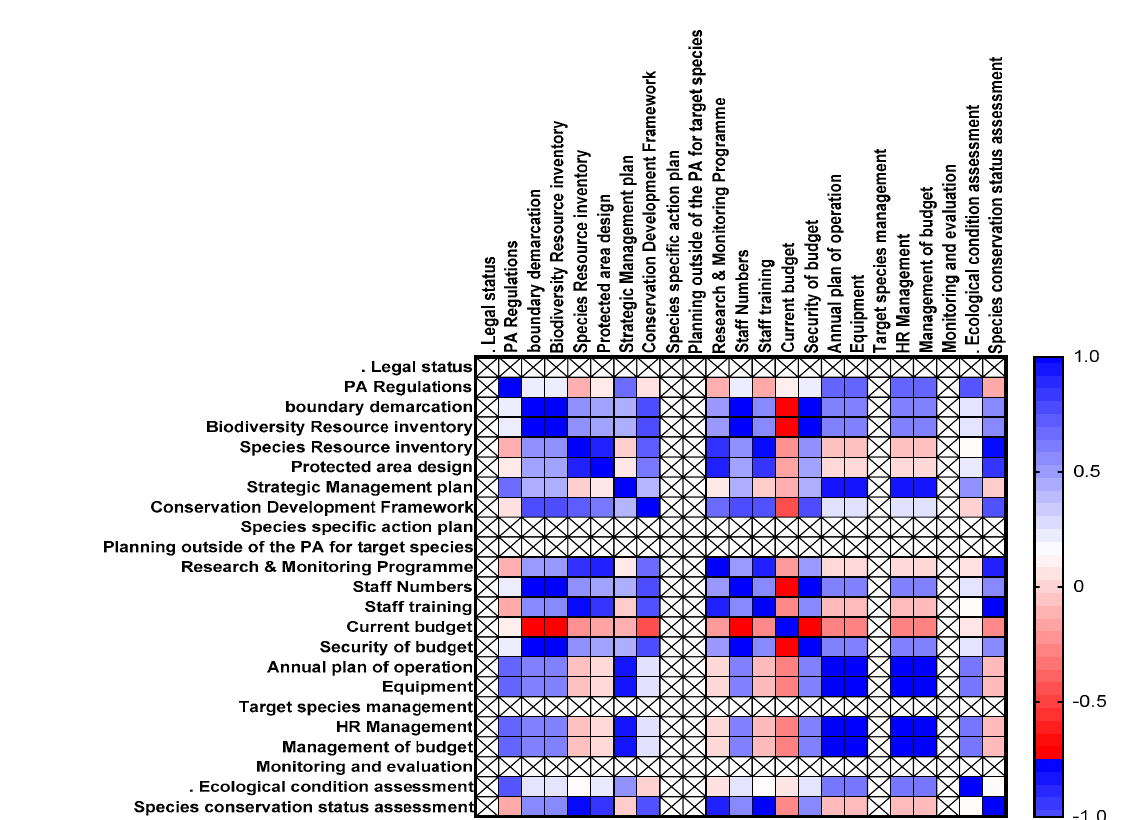
Figure 4. Correlation matrix between different variables of the contributing elements of PAME. Each line and column represent one of the questions in the Management Effectiveness Tracking Tool (METT). The color indicates the correlation with zero showing no correlation between the two questions, one (blue) showing a perfect positive correlation and minus one (red) a perfect negative correlation.